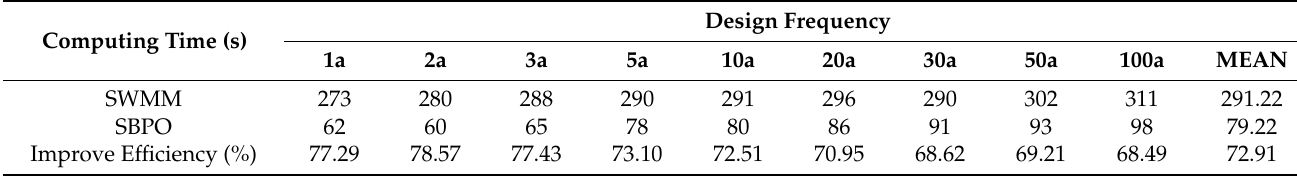
Table 3. The model computing time